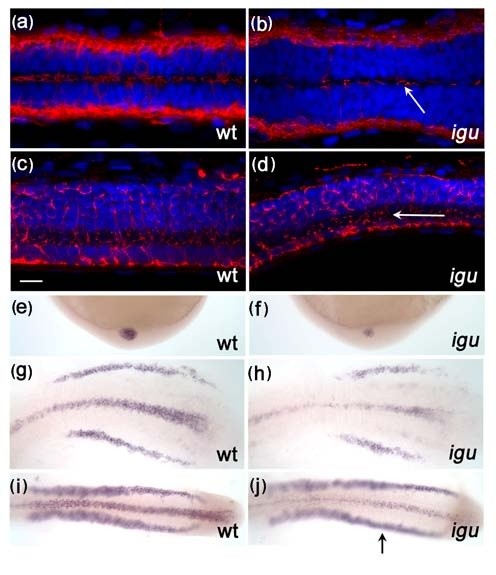
Motile cilia in the floorplate recover in Iguana (igu) mutant by 5 dpf. A few motile cilia (red: acetylated tubulin) were apparent in the floorplate of igu mutants at 48 hpf (b, arrow), and were almost completely recovered by 5 dpf (d, arrow). In situ hybridization reveals that foxj1a expression is down-regulated in Kupffer's vesicle (f) and the floor plate (h, j) at the end of gastrulation and early somitogenesis (h:8 somite, j:14somite), respectively. In contrast, expression in the pronephros was normal (j, arrow). Scale bar: 10 μm. Dorsal view: a-b & g-j, lateral view: c-f